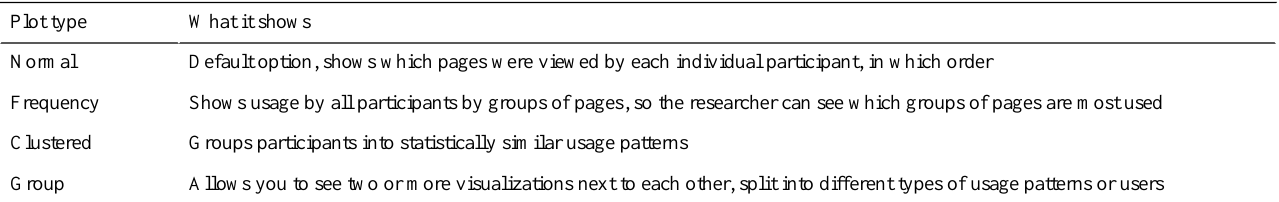
Groups participants into statistically similar usage